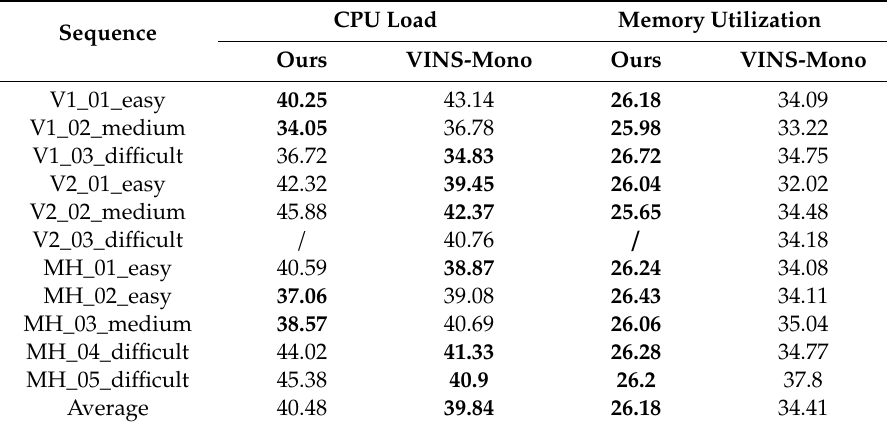
Table 1. CPU load and memory utilization statistics of the algorithms (%).